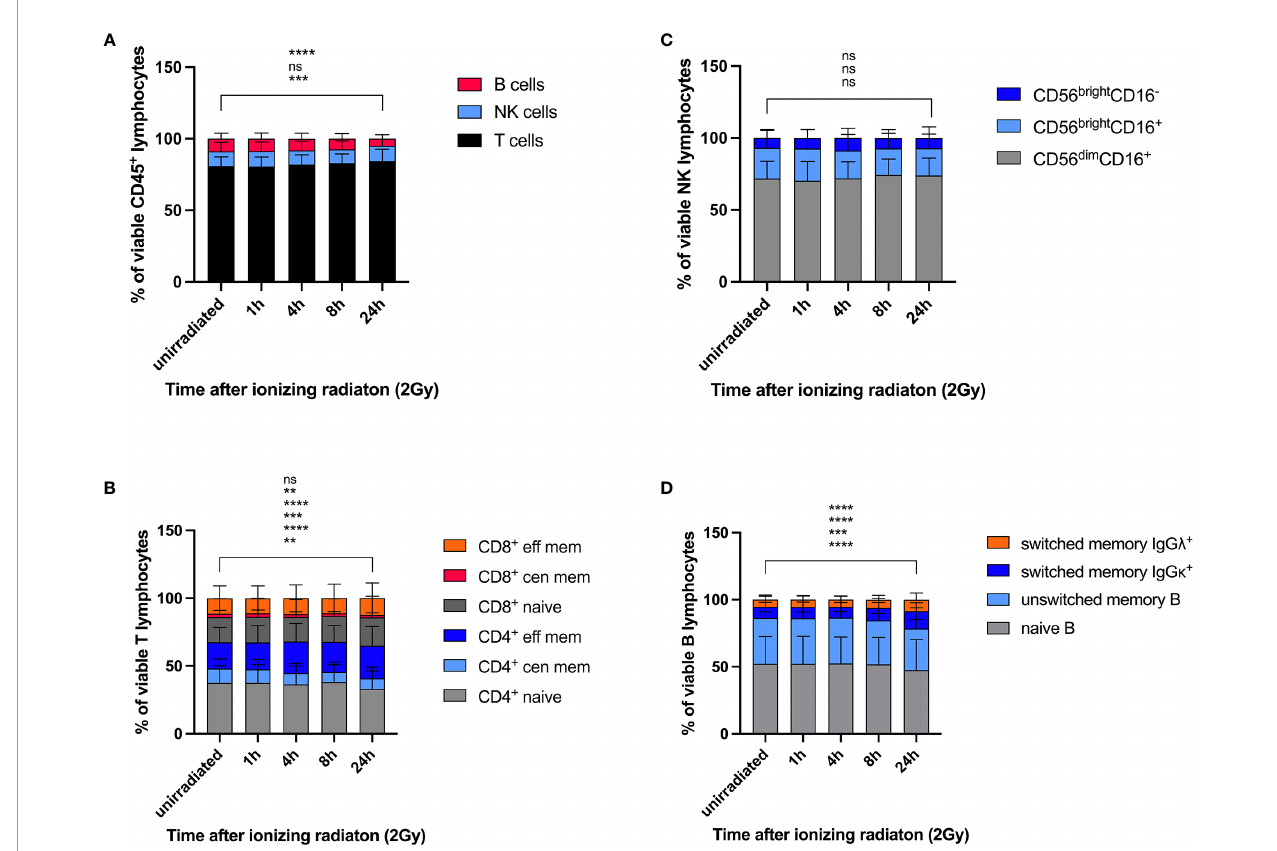
FIGURE 2 | Lymphocyte subsets show differential survival response rates to ionizing radiation. PBMCs obtained from 26 healthy donors were irradiated with 2Gy and fi xed at indicated time points. Cell counts of viable (cisplatin - ) T, NK, and B lymphocytes (A) , naïve and memory CD4 + and CD8 + T cell subsets (B) , CD56 bright CD16 - , CD56 bright CD16 + , CD56 dim CD16 + NK cell subsets (C) , and naïve and memory B cell populations (D) were compared at each time point following radiation. Statistical signi fi cance was calculated for each lymphocyte population using Turkey ’ s multiple comparison test and is shown for unirradiated lymphocytes vs. lymphocytes 24h after radiation (ns, not signi fi cant, **p ≤ 0.01, ***p ≤ 0.001, ****p ≤